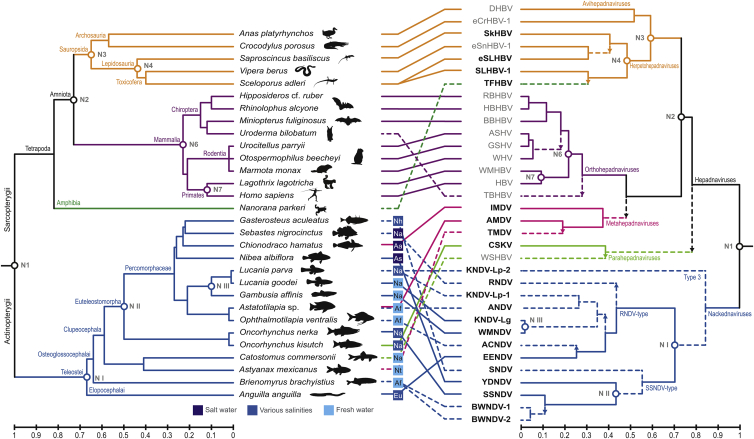
Tanglegram Juxtaposing the Host and Virus PhylogeniesLeft panel: ultrametric phylogenetic tree of the host species. Right panel: ultrametric phylogenetic tree of the virus species. Middle panel: virus-host associations. To increase the virus-host spectrum, we included endogenous hepadnaviruses from crocodilians (eCrHBV-1) (Suh et al., 2014), snakes (eSnHBV-1) (Gilbert et al., 2014, Suh et al., 2014), and spiny lizards (eSLHBV). Abbreviations for geographic regions: Aa, Antarctica; Af, Africa; As, Asia; Eu, Europe; Na, North America; Nh, Northern Hemisphere; Nt, Neotropics. Solid lines in the virus tree indicate probable separation of viral daughter lineages due to a virus-host cospeciation event; dashed lines indicate probable virus duplication, i.e., virus speciation predating separation of the extant host lineages; and dashed lines with arrow indicate a host switch and its direction, i.e., virus speciation postdating separation of the extant host lineages. Nodes marked with open circles and labeled with Arabic numerals represent putative cospeciation events that were used in our time-calibration analysis (Figures 6 and S6B). The three putative cospeciation events on the side of nackednaviruses are labeled with Roman numerals (N I—N III).